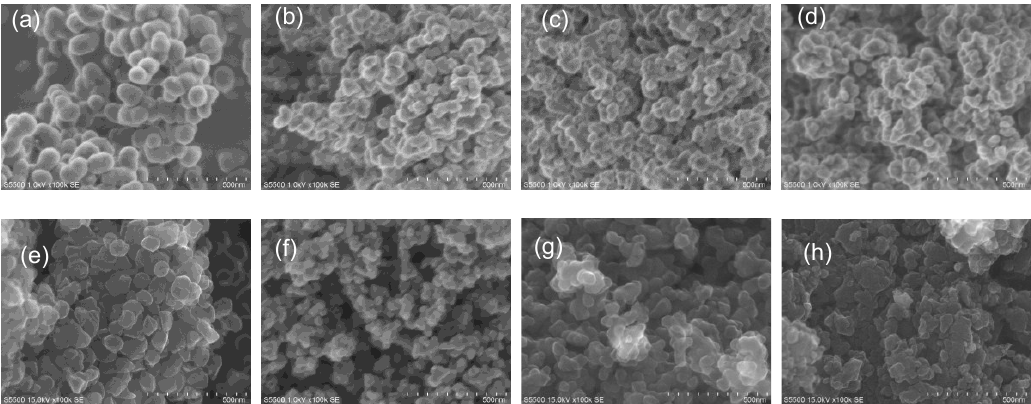
Figure 7. Field emission scanning electron microscopy (FE-SEM) images of polyimide nano-particles and Fe/N/C catalysts after carbonization. ( a – d ) are the images of polyimide samples obtained by following protocols summarized as Entry 1, 2, 3, and 4 in Table 1, respectively. ( e – h ) are the images